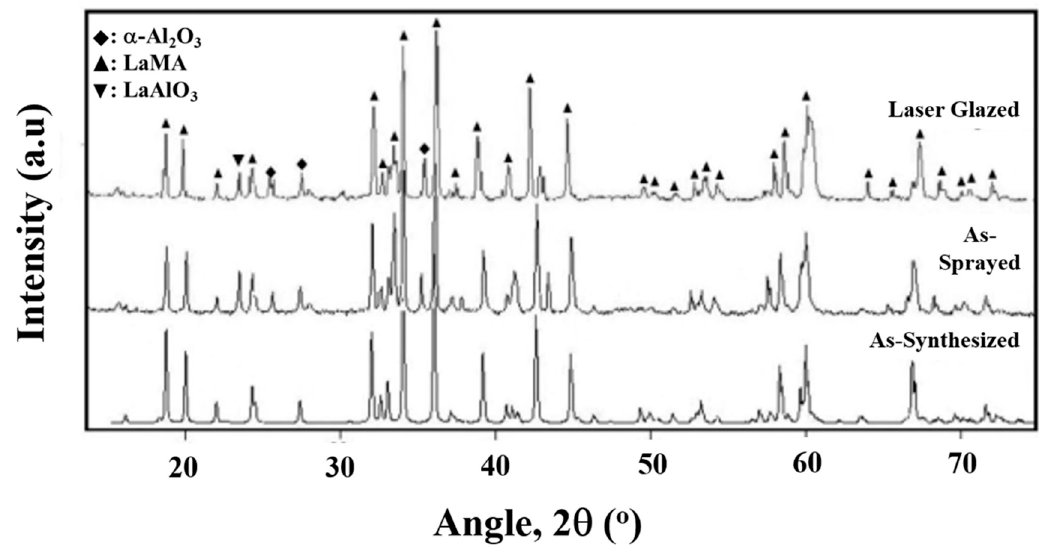
Figure 9. X-ray diffraction patterns of as-synthesised, as-sprayed and laser-glazed TBCs.